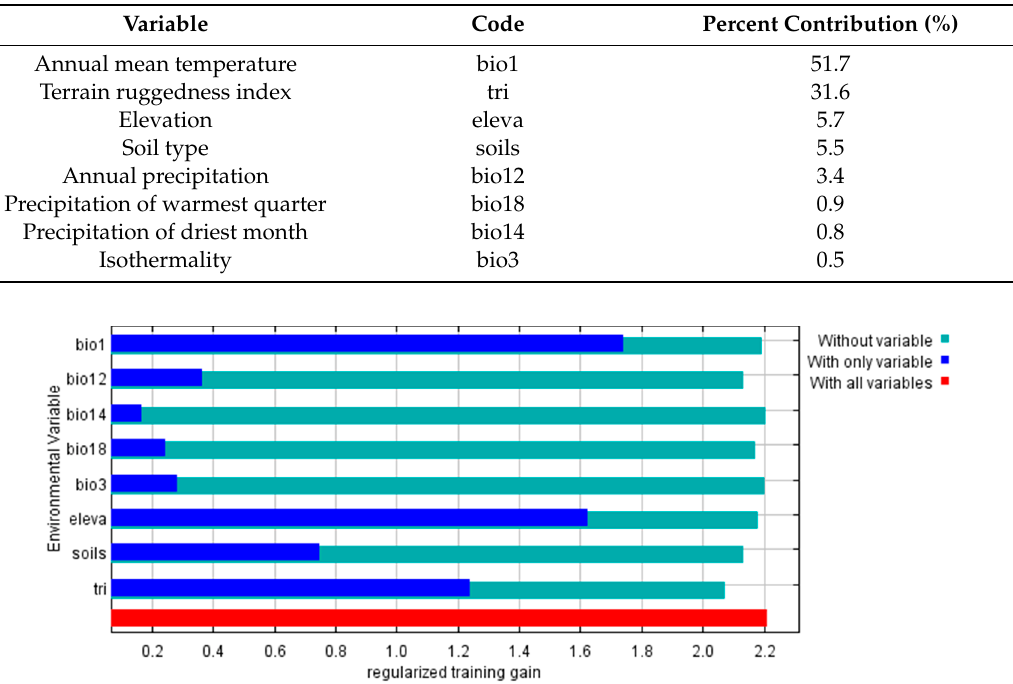
Figure 2. Jackknife test results indicating variable with highest gain when used in isolation and variable that decreases the gain the most when it is omitted. The test results indicate annual mean temperature (bio1) has the most useful information by itself while terrain ruggedness index (tri) has the most information that is not present in the other variables. Jackknife of regularized training gain for P. africana .